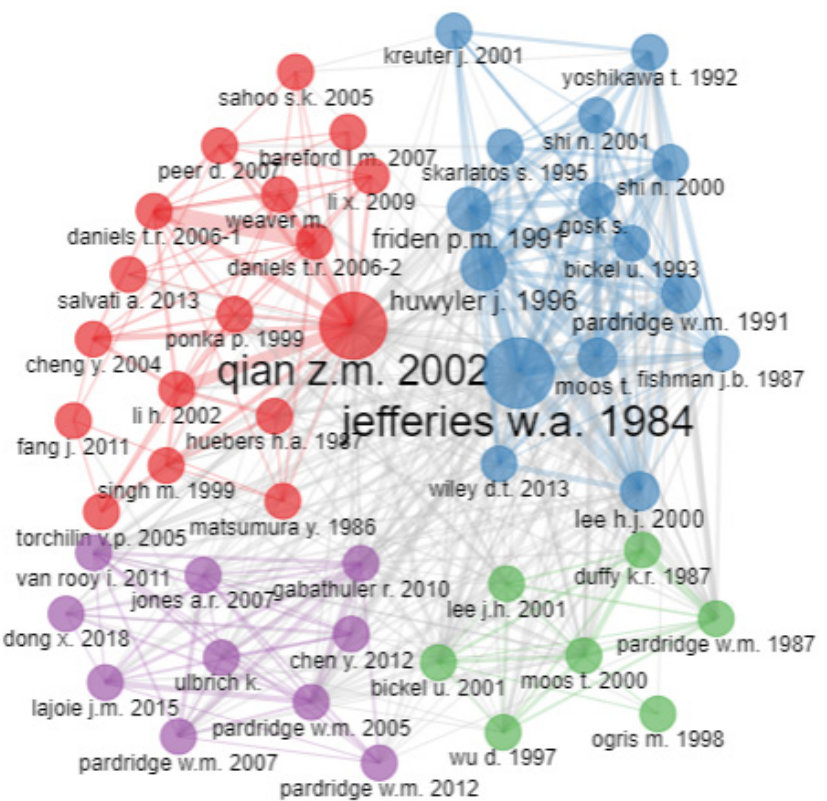
Figure 9. Co-citation network. Source: Authors’ elaboration using the Bibliometrix R-package.